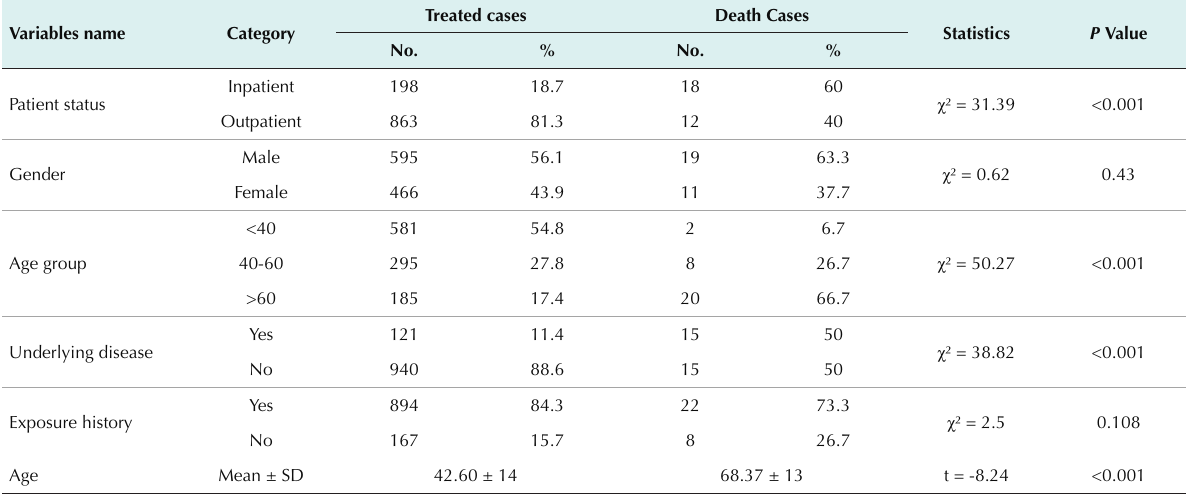
Table 3. Comparison of Death Rates According to the Studied Variables Variables